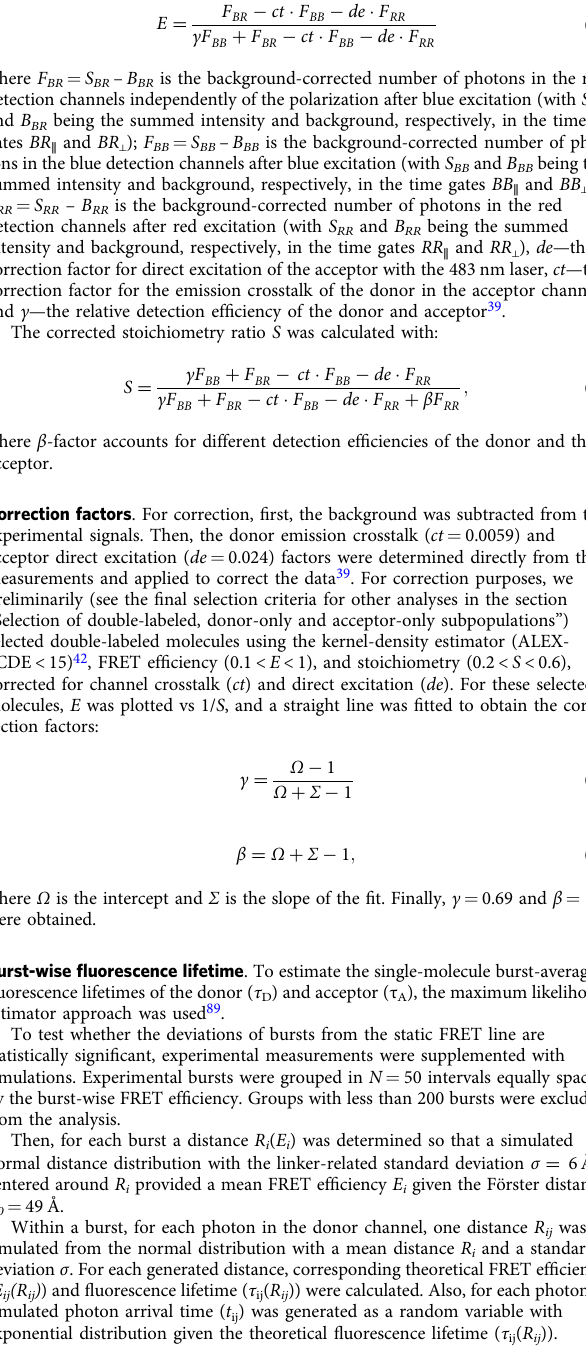
FRET ef fi ciency and stoichiometry . The absolute burst-averaged FRET ef fi ciency E was calculated as: